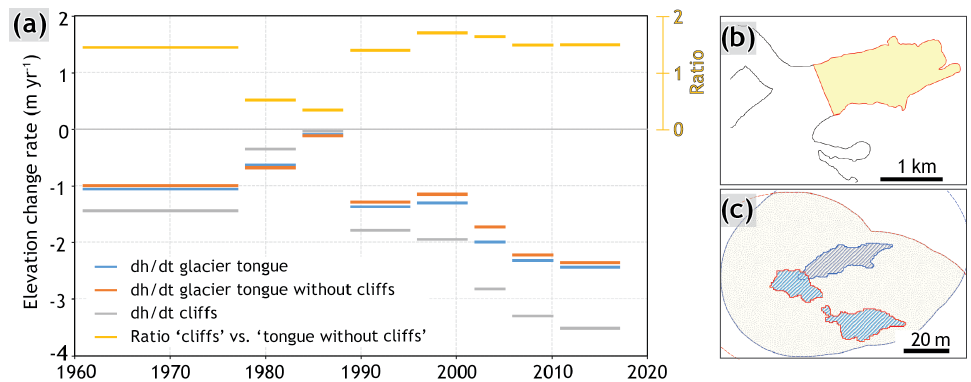
Figure 9. Influence of ice cliffs on total elevation change rate over the lowest area of the glacier tongue for eight time periods from 1961 to 2017. (a) Elevation change rate periods; (b) area that was considered “tongue” for elevation change analysis; (c) examples of ice cliffs of two different years (2005 in red; 2001 in blue), the corresponding borders of the 35m buffer, and the overlapping area of this buffer (yellow, grey dotted